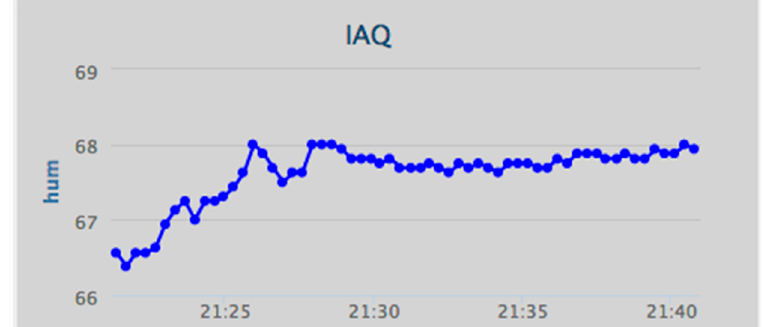
Figure 9. Data visualization: relative humidity (%).